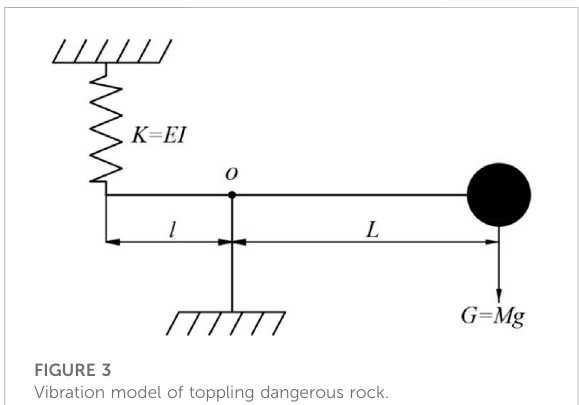
FIGURE 2 Simpli fi ed mechanical model of toppling dangerous rock.